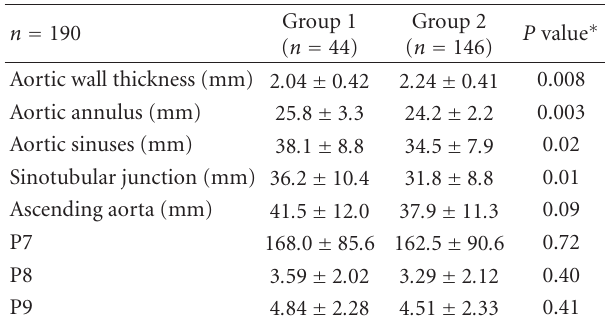
Table 3: Transesophageal dimensions and TSC